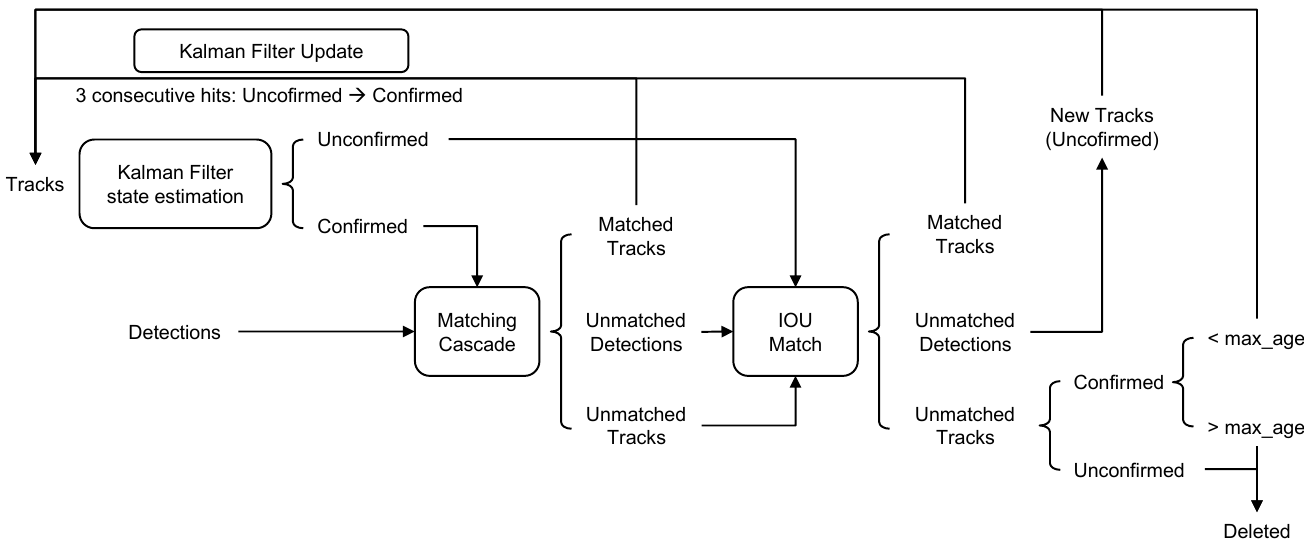
Figure 5. DeepSort tracking algorithm